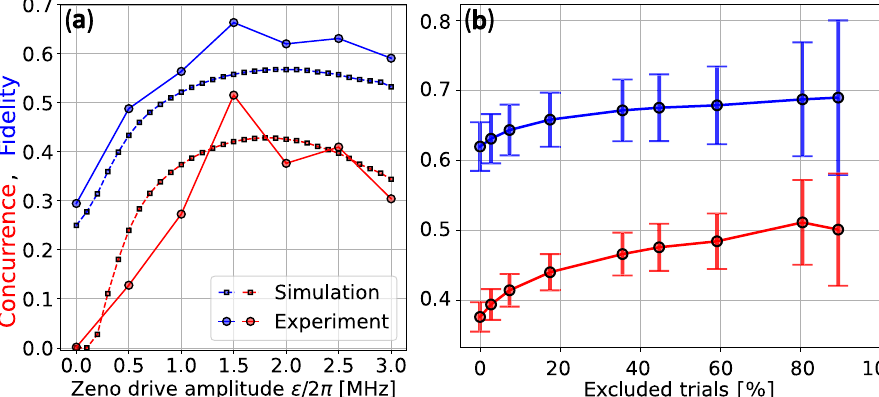
Fig. 4 Zeno gate performance. State fi delity (blue) and concurrence (red) versus the amplitude of the Zeno drive a , and as a function of the percentage of trials that were excluded in the post-selection procedure for a Zeno drive amplitude of 2 MHz b . The fi delity is calculated with respect to an ideal state, obtained by applying 1 (cid:2) 2 eg j i eg h j to our initial state þþj i . Circles are experimental results and squares are numerical results (lines are guide to the eye). The error bars in b represent the standard error of the